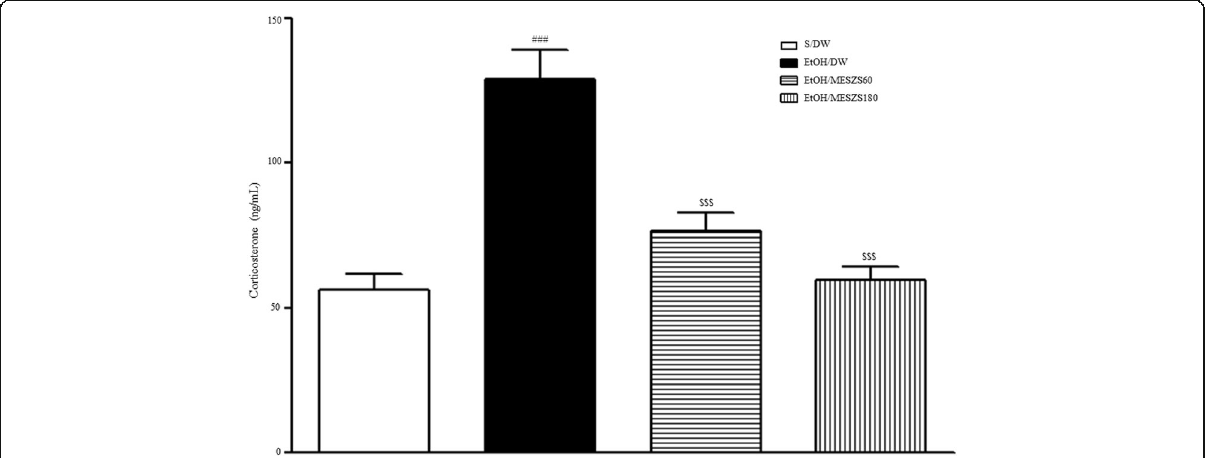
Fig. 4 Effects of MESZS on plasma CORT concentrations during EtOHW. Withdrawal from chronic EtOH administration increased plasma CORT levels in rats, which was prevented by MESZS treatment. All data are expressed as a mean ± SEM ( n = 8). S: saline, DW: distilled water, EtOH: ethanol, CORT: corticosterone; MESZS: methanol extract of Semen Ziziphi Spinosae , MESZS60: 60 mg/kg/d MESZS, MESZS180: 180 mg/kg/d MESZS. ### p < 0.001 vs. S/DW group; $$$ p < 0.001 vs. EtOH/DW group (one-way ANOVA followed by Newman-Keuls post hoc